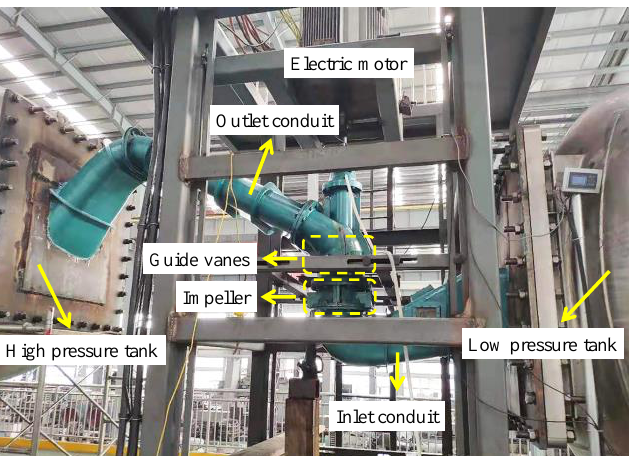
Figure 1. Model test rig for the axial flow pump with a low head.